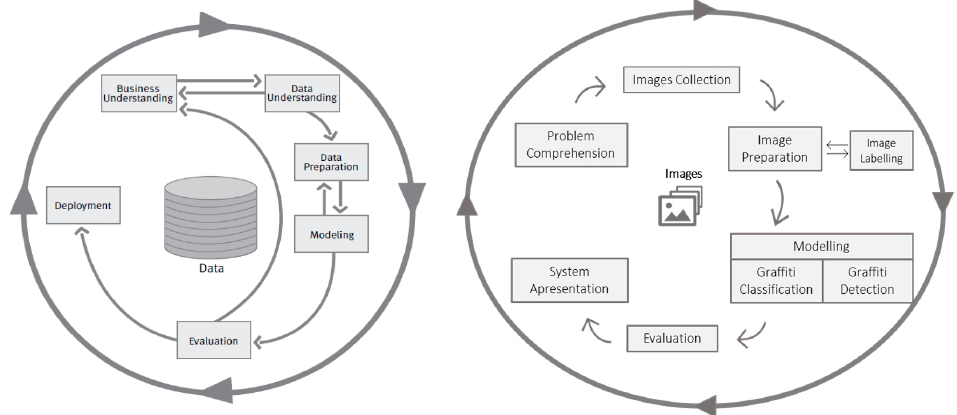
Figure 3. CRISP-DM ( left ) and CRISP-DM proposed adjustments ( right ).